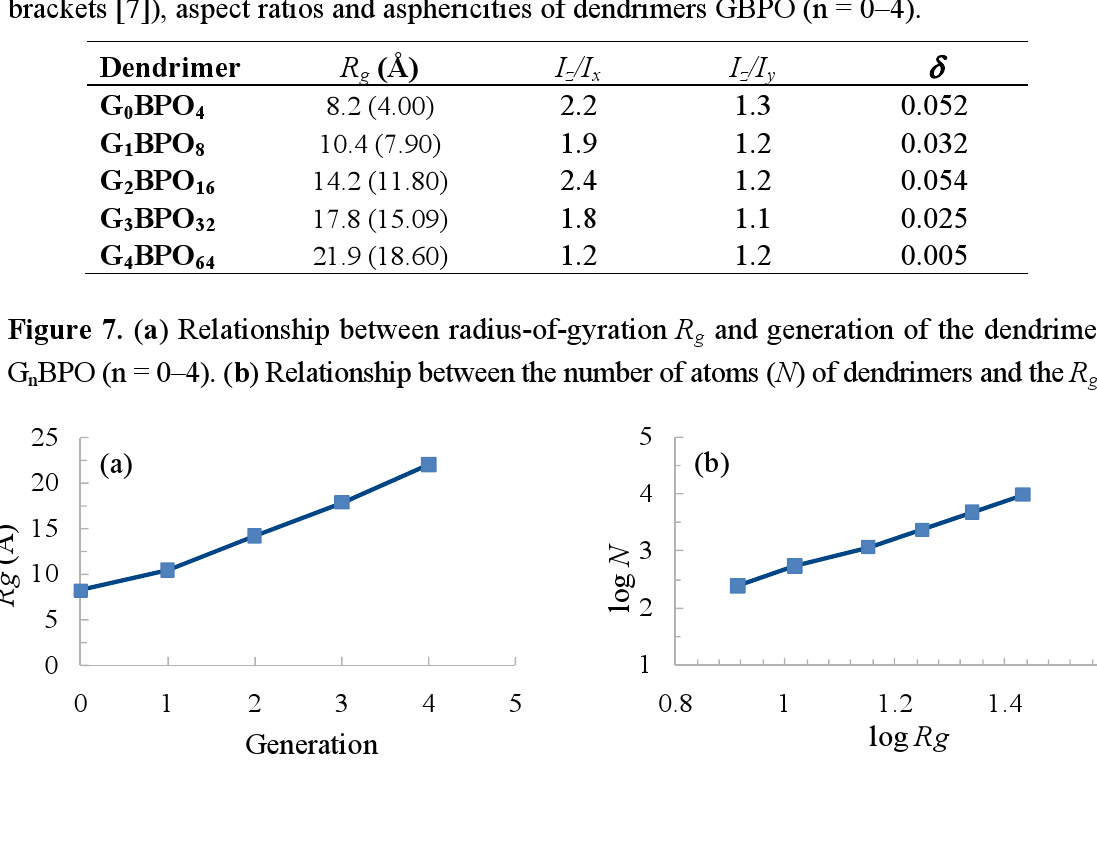
Table 7. Radius-of-gyration (the experimental values determined from the Small Angle X-ray Scattering (SAXS) spectra for unfunctionalized PAMAM dendrimers are shown in brackets [7]), aspect ratios and asphericities of dendrimers GBPO (n = 0–4).